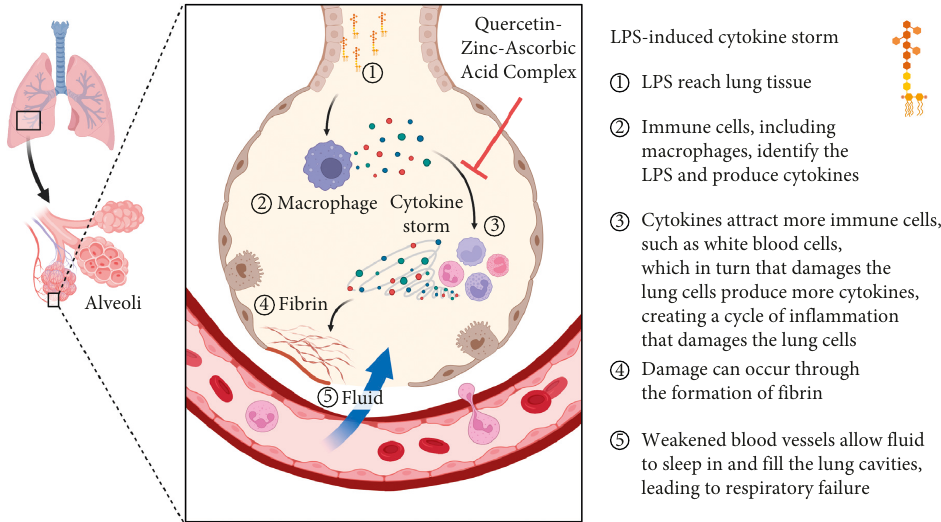
Figure 1: Proposed mechanism for LPS-induced cytokine storm and the proposed interference of the novel